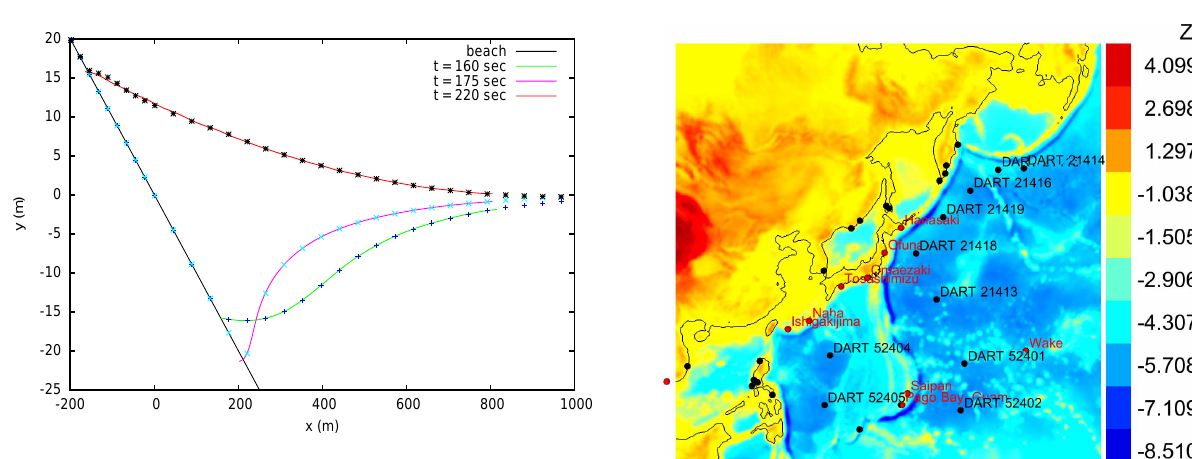
Fig. 4. Extent of the simulation domain and bathymetry (altitude in metres). DART buoys (black labels) and GLOSS stations (red